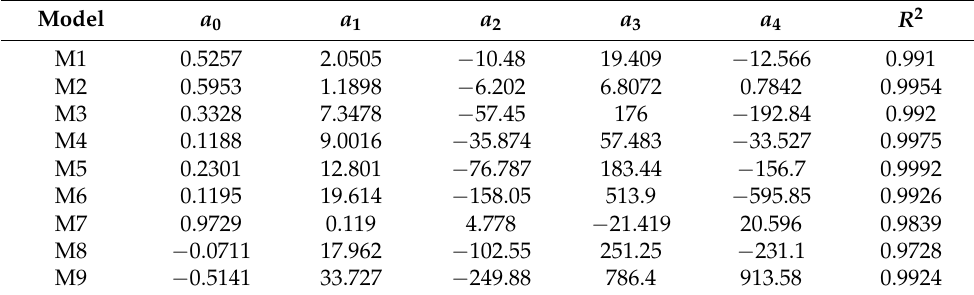
Figure 13. Variations in the discharge coefficient, C L , as a function of the H T / P ratio for the M9 model. Table 3. Coefficients and R 2 values of the polynomial